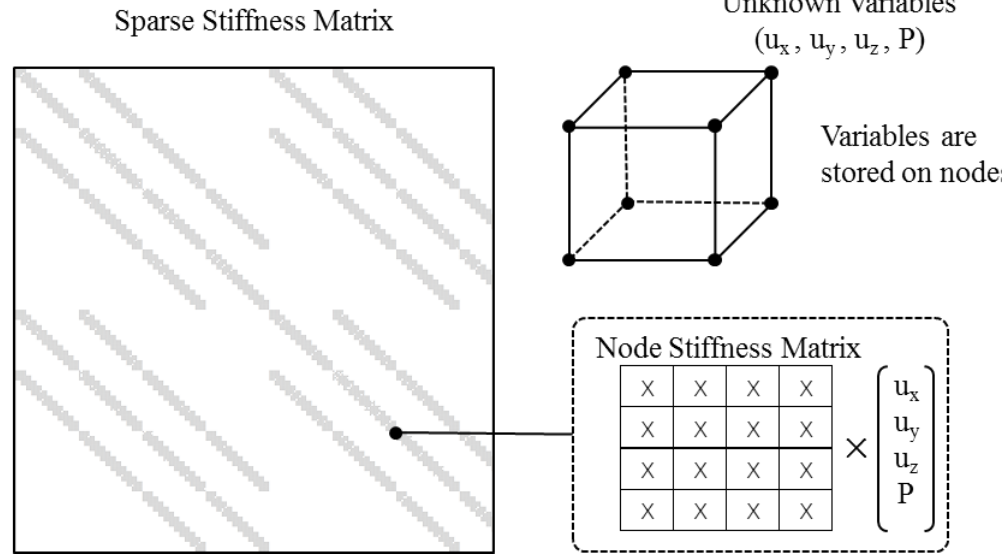
Figure 2—Stiffness matrix form for FEM.